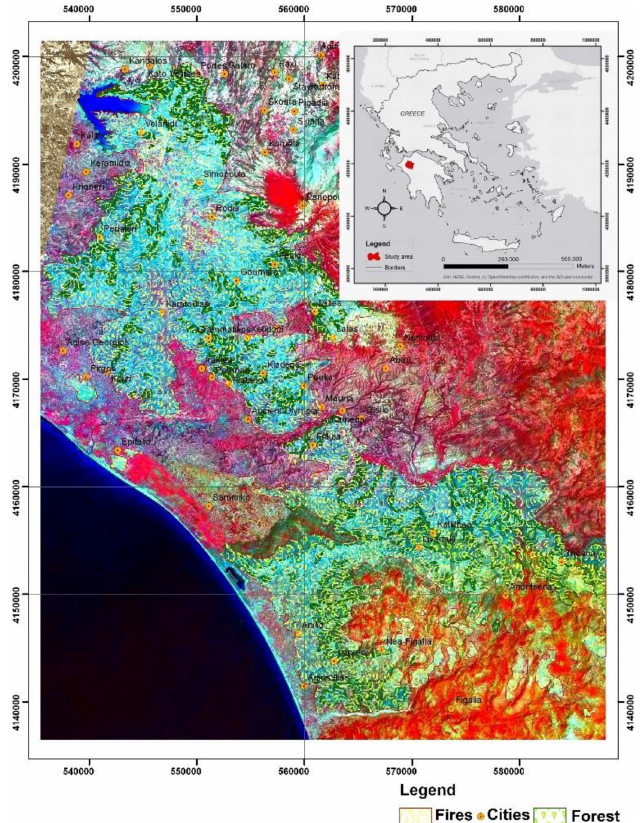
Figure 3. The burned area presented in a Spot imagery map.